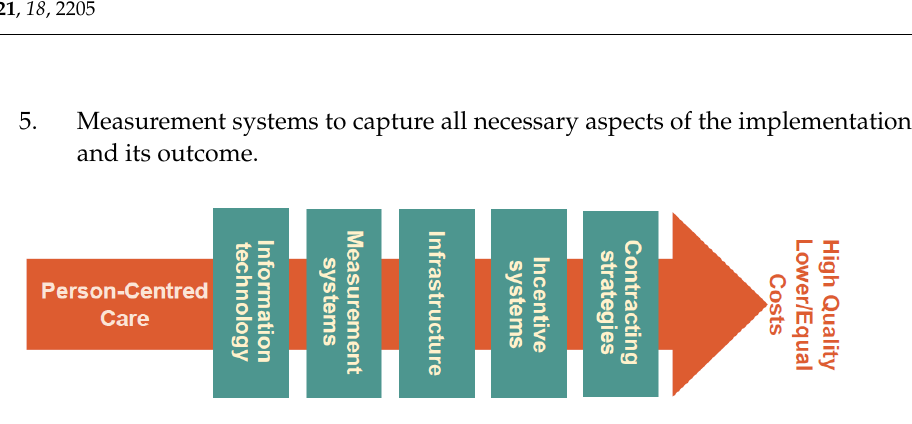
Figure 1. The dimensions and critical enablers of the WE-CARE Roadmap. Source: modified from [7,23].